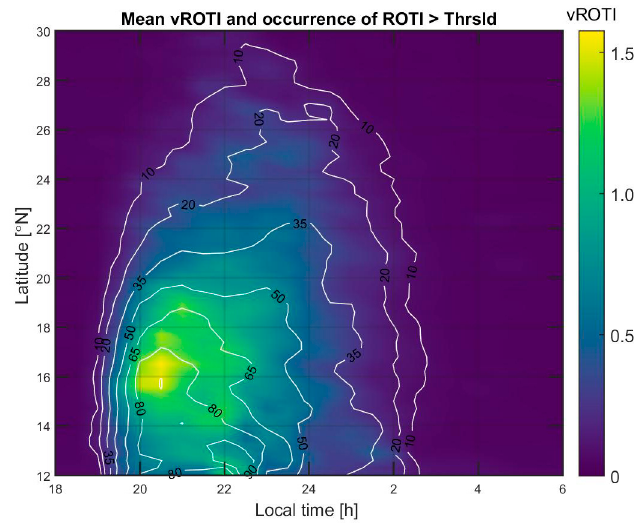
Figure 4. Mean vROTI (color) and occurrence of EPBs (ROTI > threshold, white contour lines) in local time and latitude.